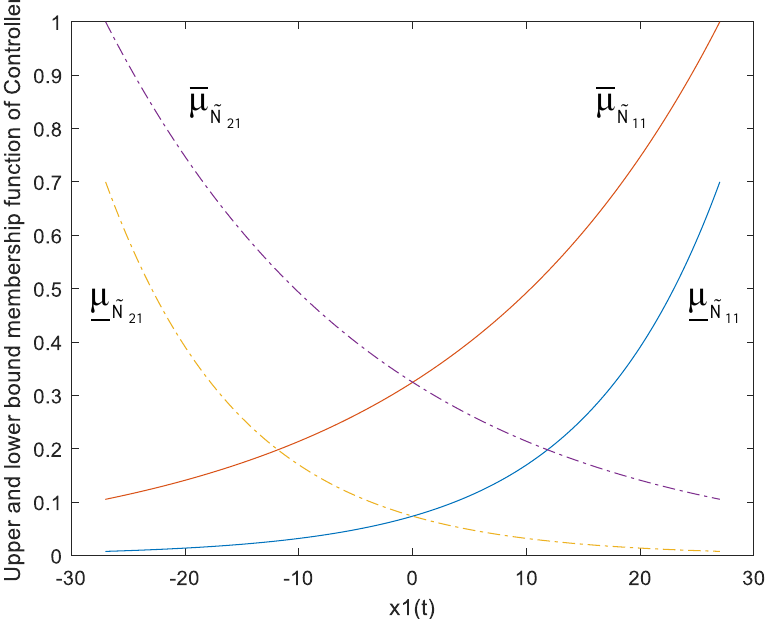
Figure 4. IT-2 membership functions of fuzzy controller.